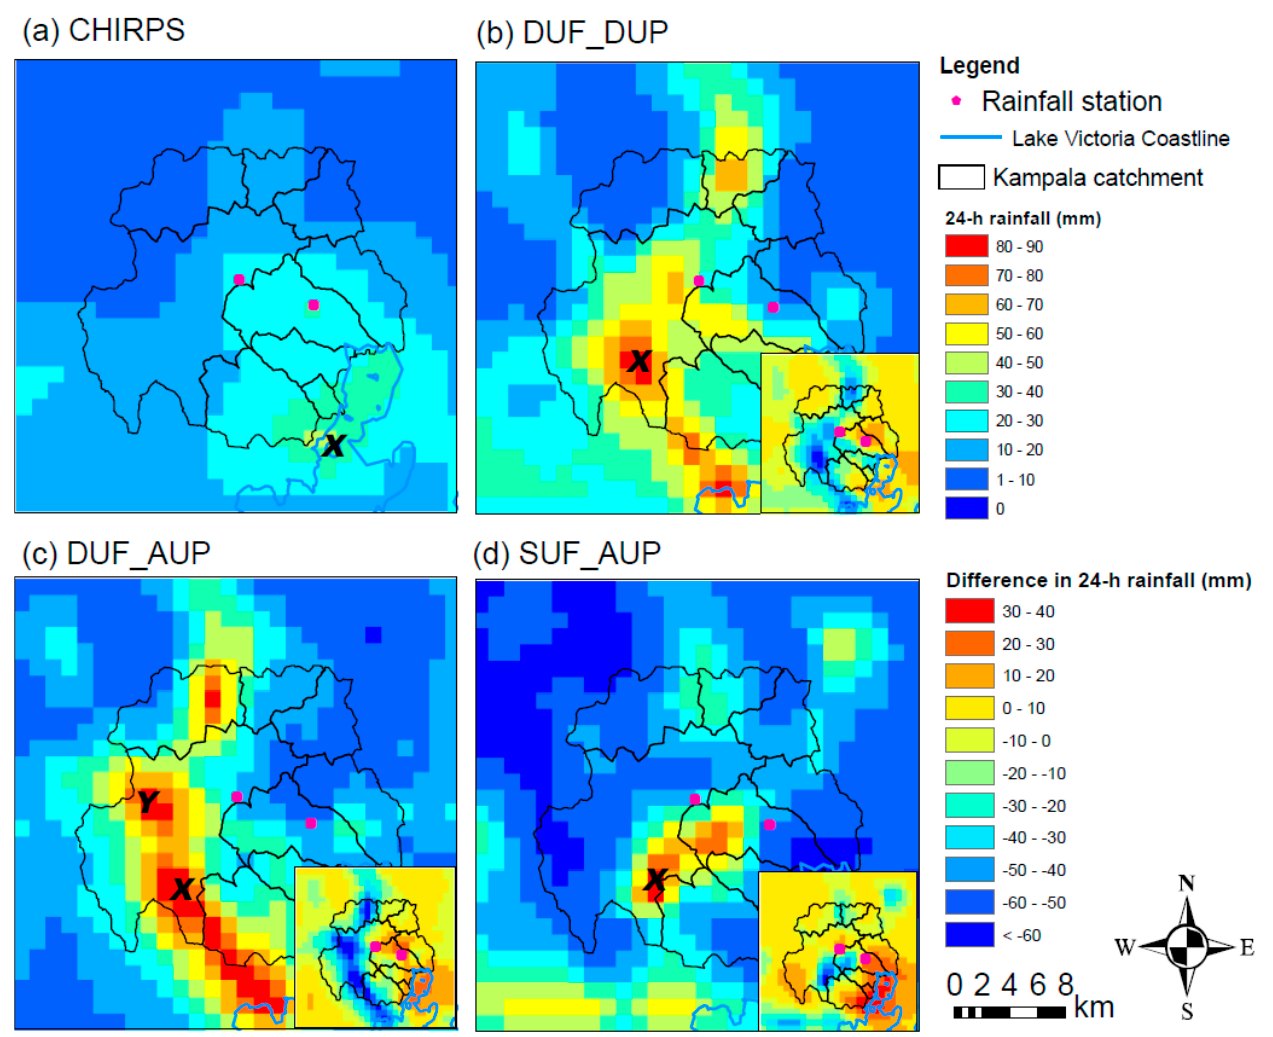
Figure 4. 24 h accumulated rainfall for ( a ) CHIRPS, ( b ) DUF_DUP, ( c ) DUF_AUP, and ( d ) SUF_AUP simulations. The insets in the bottom-right corner in ( b – d ) are the difference in the 24 h accumulated rainfall in the DUF_DUP, DUF_AUP, and SUF_AUP simulations from the CHIRPS observation, re- spectively.